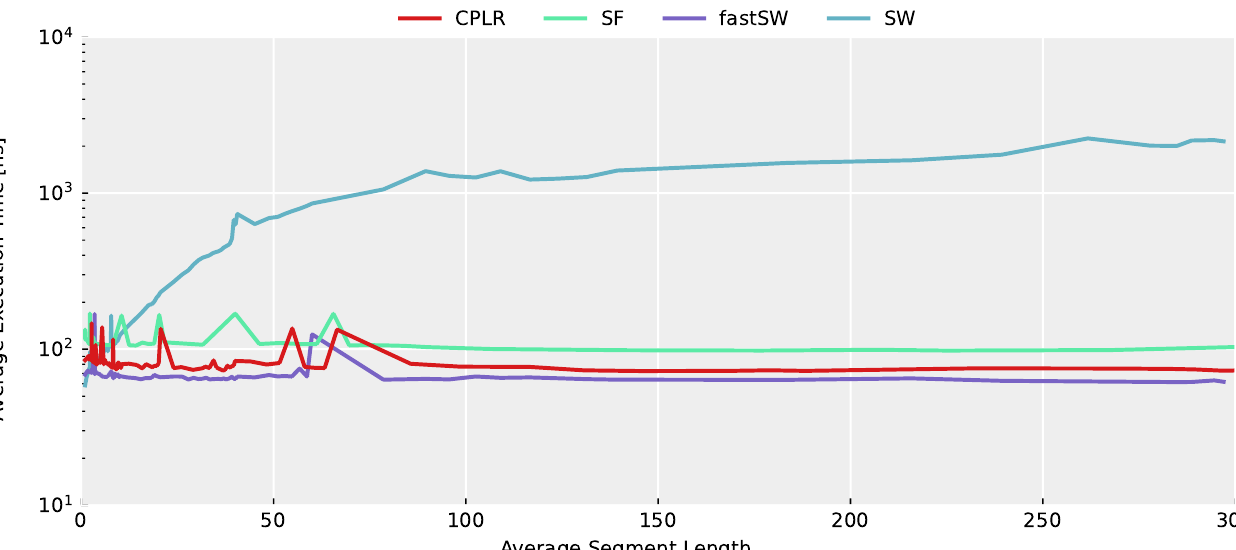
Figure 3. Average execution time per sample plotted against the resulting average segment length of each PLA algorithm applied to the entire TNT15 dataset at a high range of threshold values on an x86_64 architecture. For the sake of comparison, the execution time is plotted in a logarithmic scale. CPLR, SF, and fastSW show a constant execution time, while SW shows a linear average execution time, with respect to the average segment